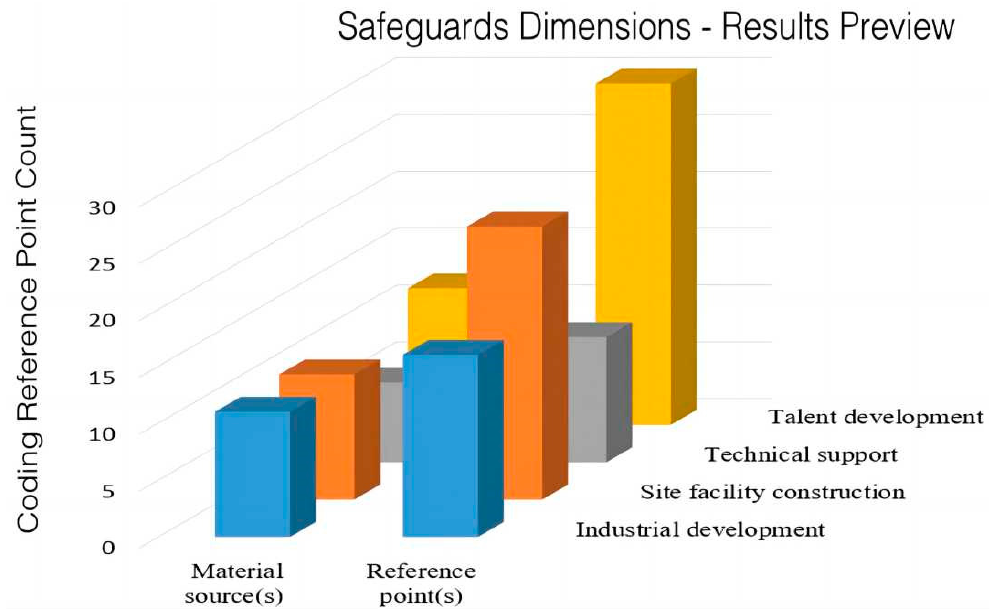
Figure 4. Distribution of reference points for safeguard measures for the integration of sports and medicine.